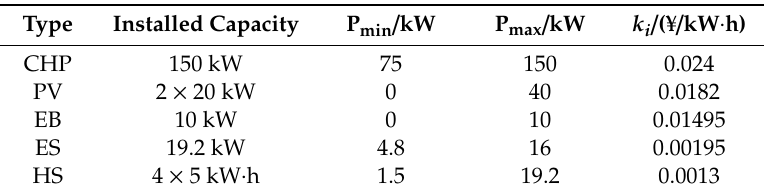
Table 1. Time-of-use price.